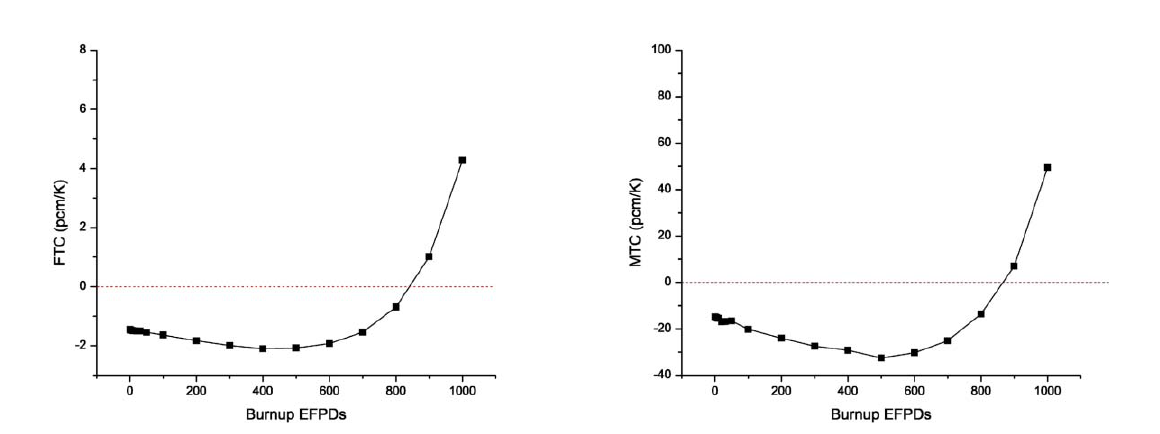
Figure 8. Temperature coefficients of reactivity.